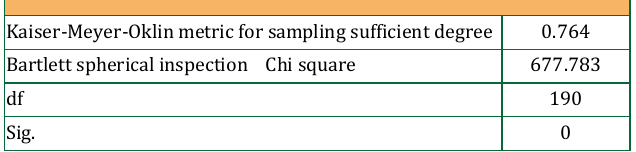
Table 2: Validity measurement